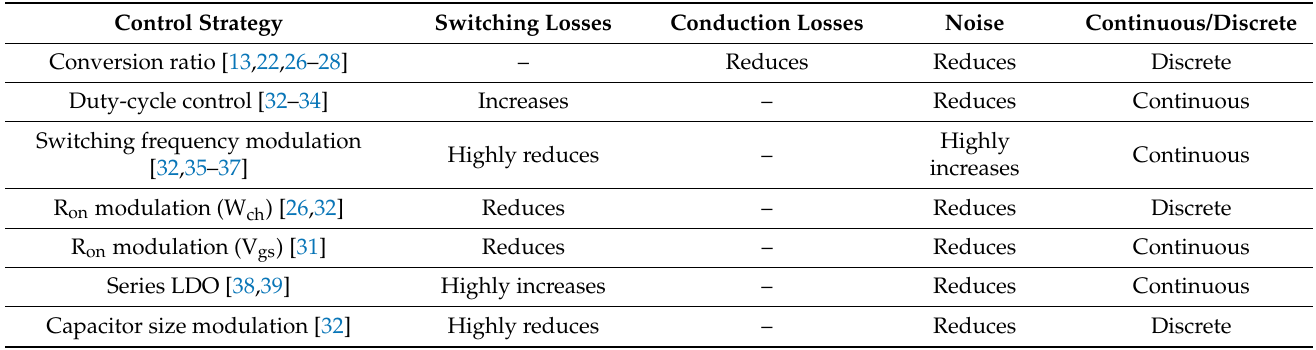
Table 2. Different control schemes comparison of